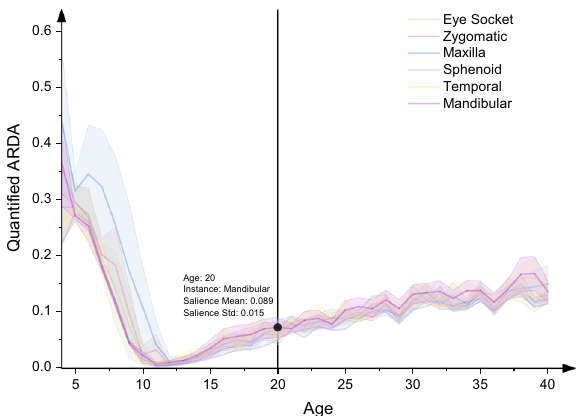
Fig. 8 The distribution of ARDA across instances and ages. The threshold of the ageing-signi fi cant region is set to the 75-th percentile. For each instance, the points on the line and the interval indicate the mean of the ageing salience and the interval of mean ± standard deviation of the ageing salience, respectively. A point in the instance of mandibular bone is selected as the example. This point shows that the mean and standard deviation of the ageing salience of 3018 subjects are 0.089 and 0.015 for mandibular bone at the age of 20 years, respectively.